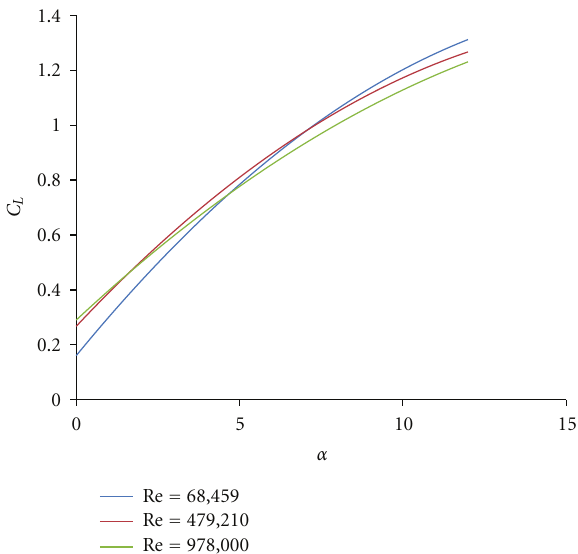
Figure 9: CFD simulation results of C L versus α of NACA 63-421 airfoil.